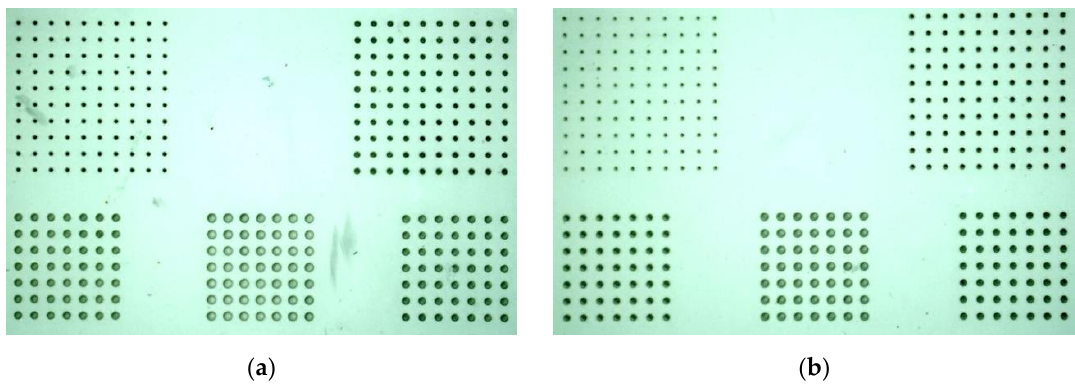
Figure 5. Two of the samples after lamination: ( a ) the one with HEC 2 wt% and ( b ) the no sacrificial volume material (SVM) sample.